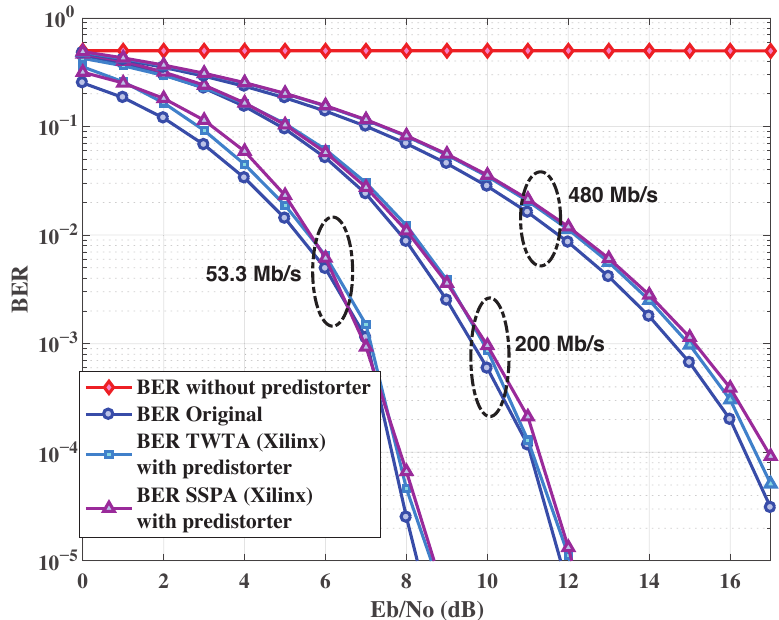
Figure 15. Bit Error Rate without and with NN pre-distorter for CM2.